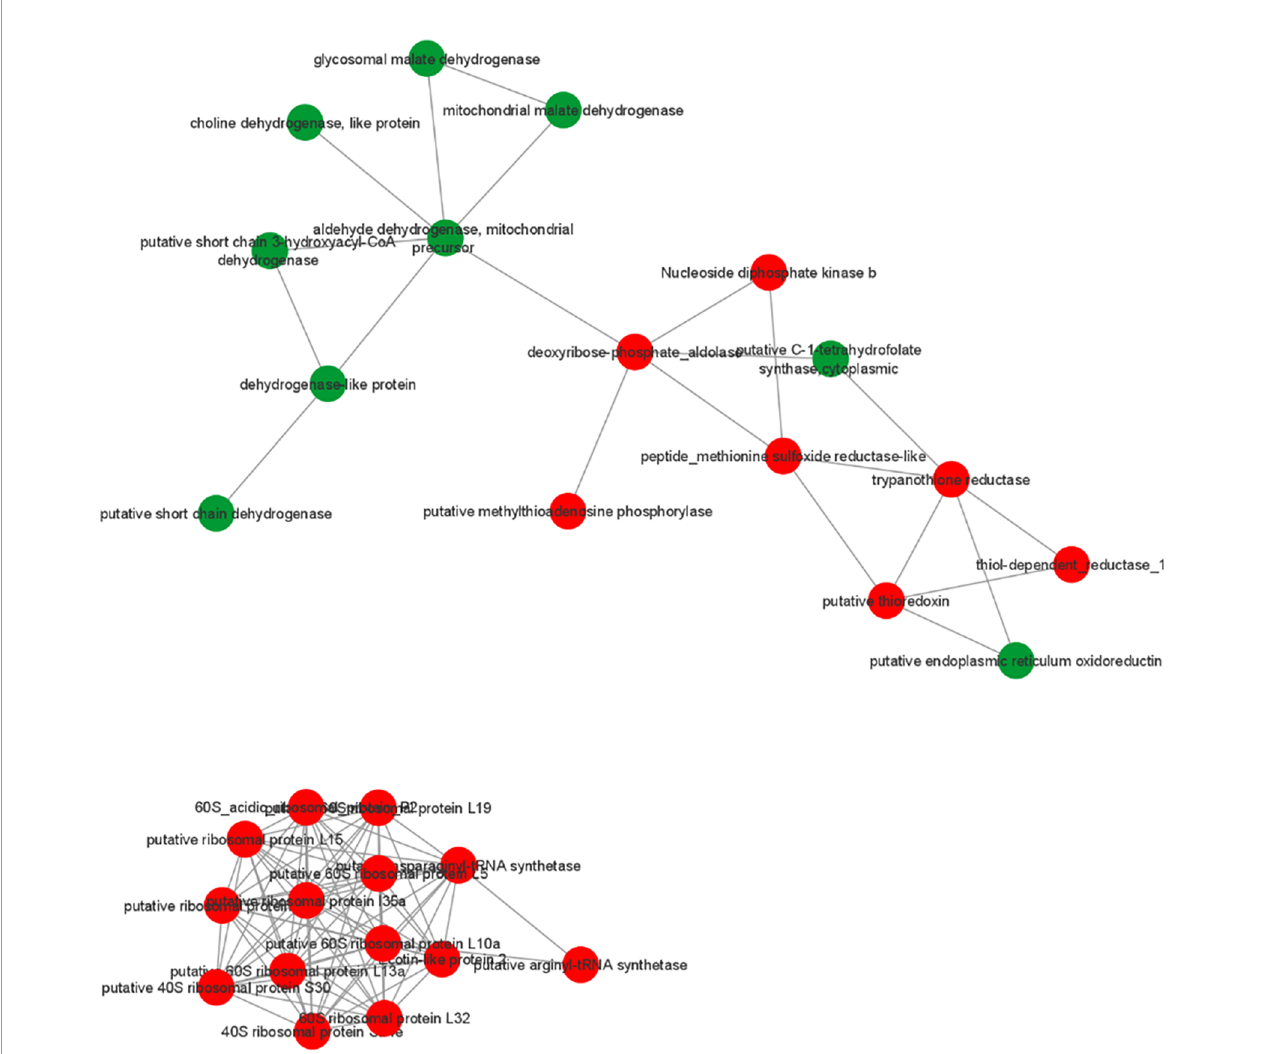
FIGURE 3 | Prediction of interaction among differentially abundant proteins in L. braziliensis that are part of enriched GO categories. Red and green represents upregulated and downregulated proteins in LbAL vs LbTL